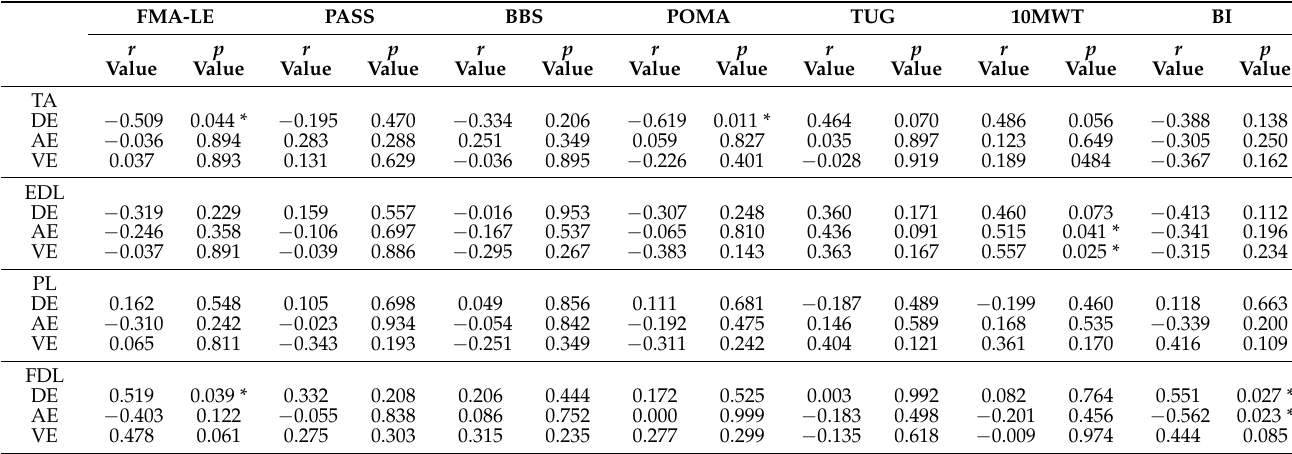
Table 4. Correlations of muscle perception performances with clinical motor and functional outcome measurements ( n = 16).